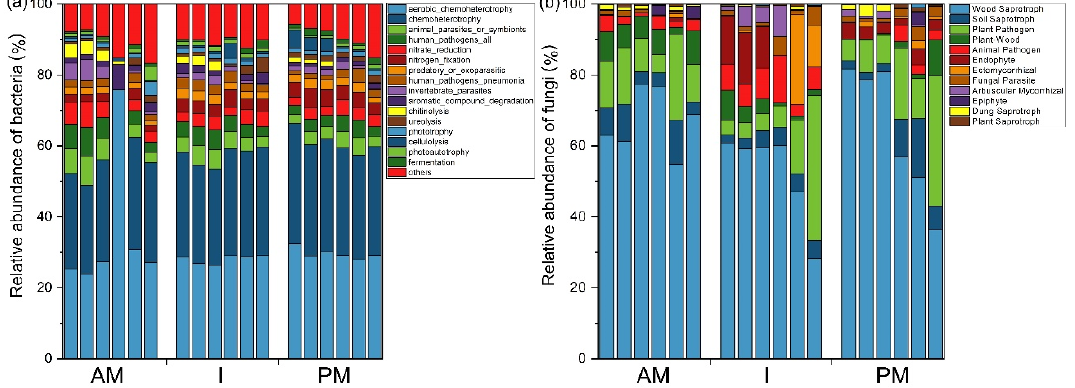
Figure 6. Predicted functional profiles of the soil bacteria ( a ) and fungi ( b ) with different planting mode. AM represents areca nut monocropping; I represents areca nut intercropping with pandan; and PM represents pandan